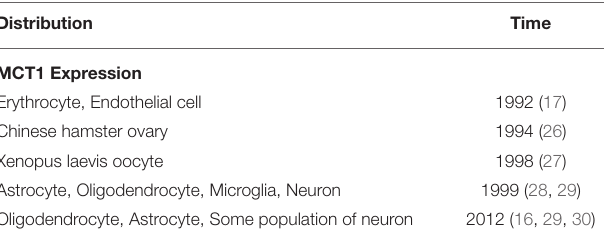
TABLE 1 | Expression and Distribution of